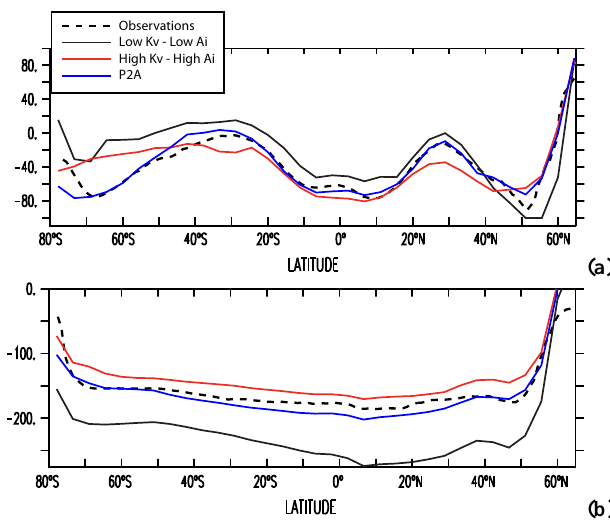
Estimates from observations (including inverse models and a data-assimilating forward model)